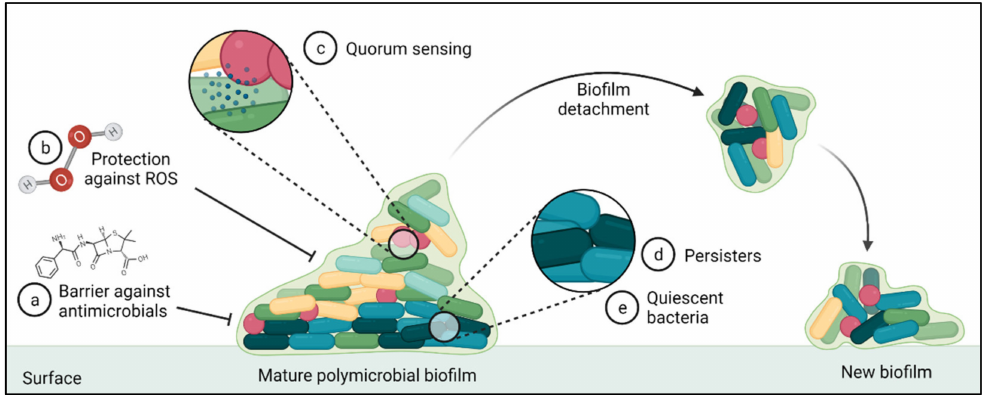
Figure 5. Different mechanisms that contribute to the resilience of biofilms and higher antimicrobial resistance. (a) Extracellular polymeric substance (EPS) that acts as a barrier to the diffusion of antimi- crobials and other substances. (b) Up-regulation of the protective mechanisms against reactive oxygen species (ROS). (c) Bacterial signaling with the ability to activate virulence factors that also contributes to biofilm formation and detachment, or resistance against ROS amongst others. (d) Presence of highly-antimicrobial resistance bacterial sub-populations called persisters. (e) Bacteria present in the lower layers of a biofilm that present differential gene/protein expression and slower rates of growth that reduces effectiveness of antimicrobials. Source: [134]. Created with